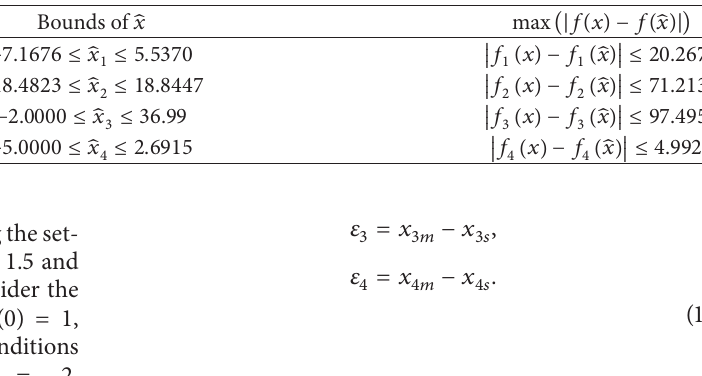
Table 1: Estimation of the upper bounds of assumption